Question: Which kind of chart has been used to present this data?
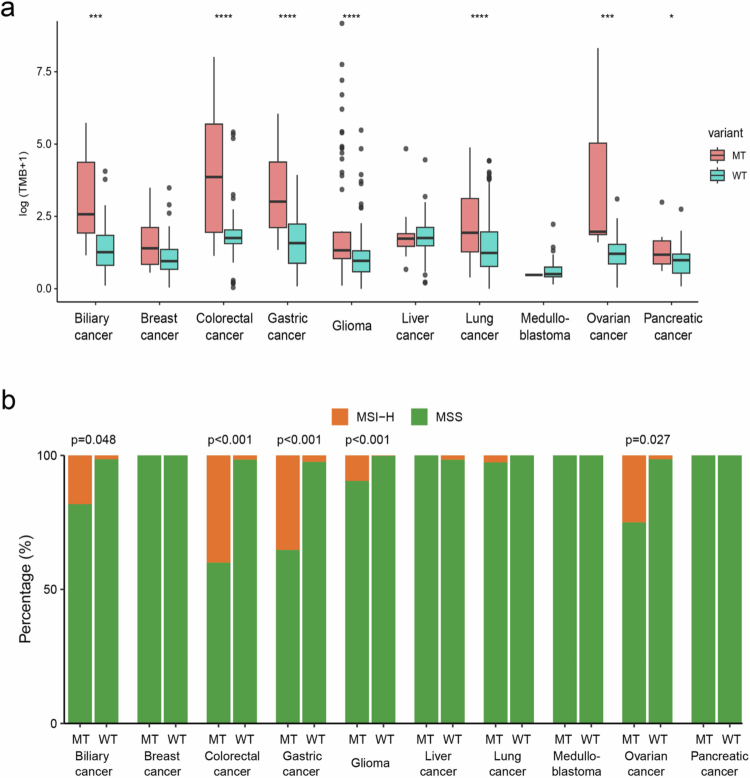
Answer: box